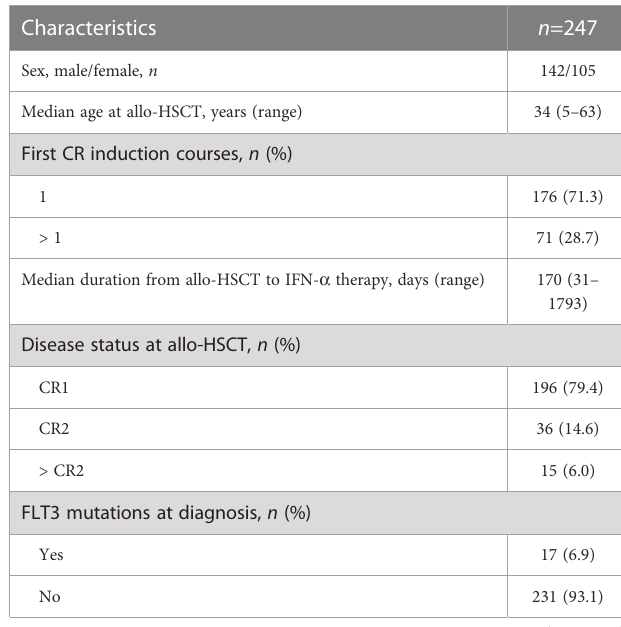
TABLE 1 Patient characteristics of patients receiving preemptive IFN- a